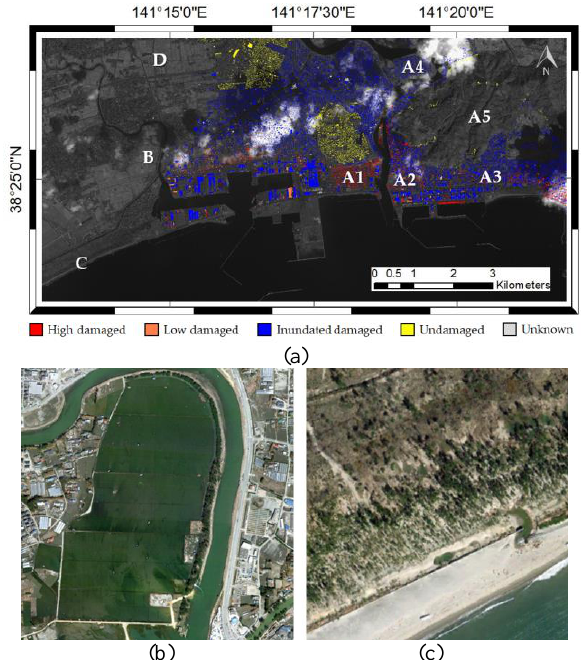
Figure 3. Derived components: (a) Simulated POAs; (b) Figure 2. (a) Building damage map. The regions of interest PolSAR POAs; (c) NDVI; (d) SPAN; and (e) Entropy. (ROIs) for the validation are labelled as A1 to A5 , B , C , and D ; (b) The GoogleEarth image of the inundated cropland, B ; and (c) The GoogleEarth image of the damaged forest (windbreak), C .